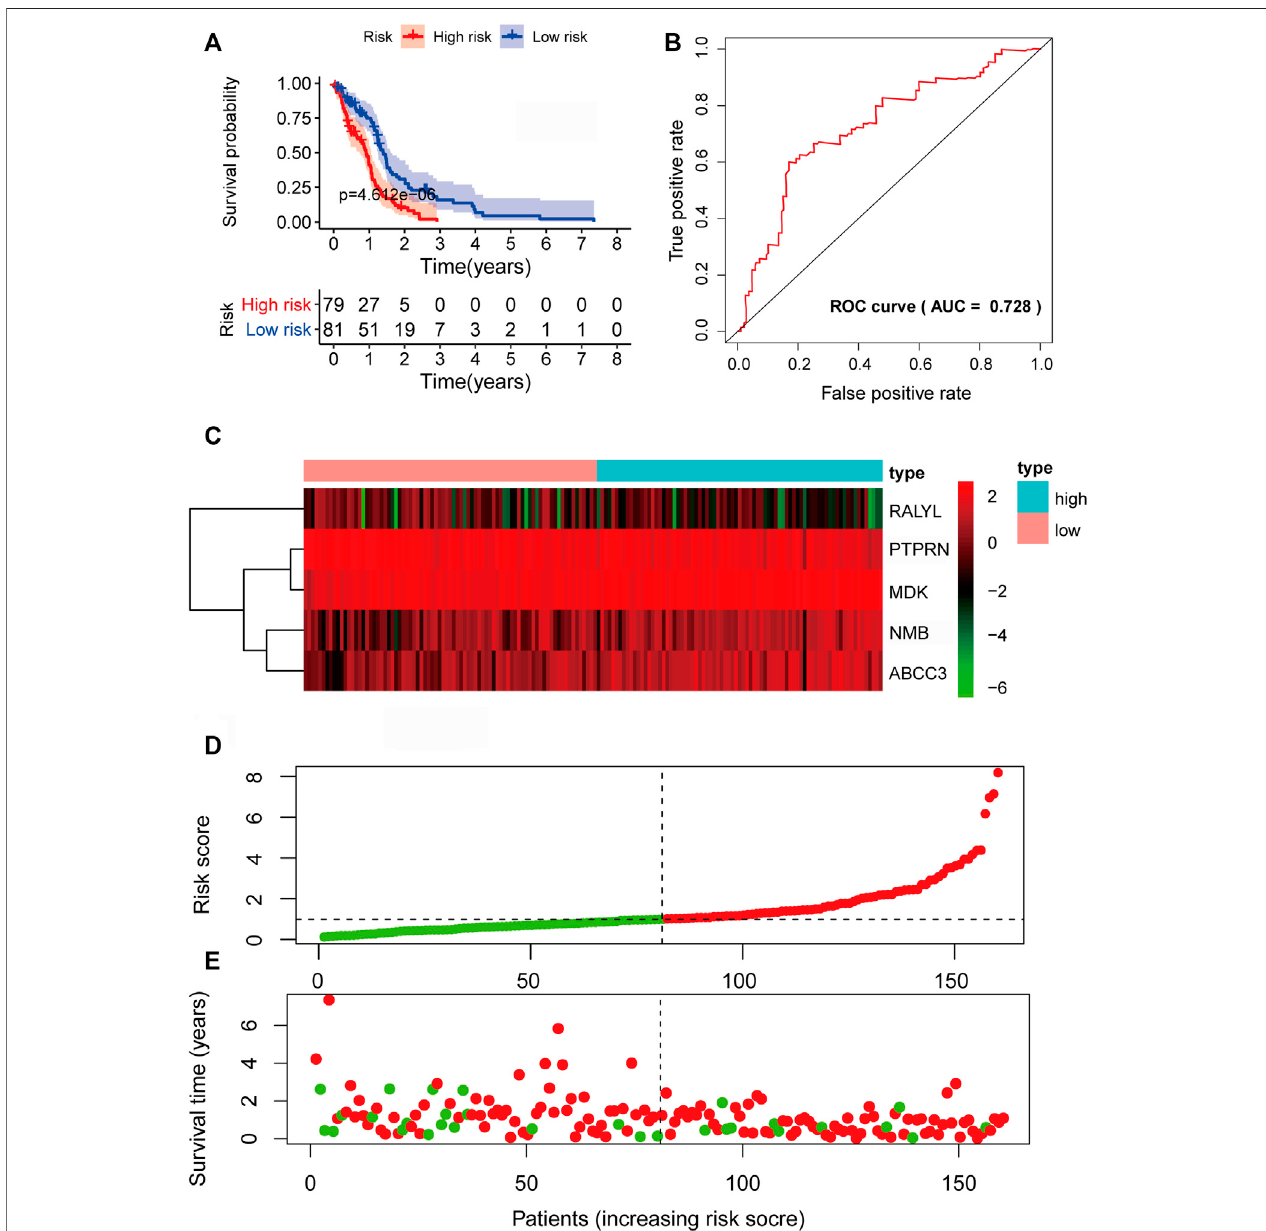
FIGURE 6 | Prognostic evaluation of the fi ve-mRNA signature in The Cancer Genome Atlas (TCGA) set. (A) Kaplan – Meier survival curve for patient overall survival (OS) in the entire TCGA set. (B) Receiver operating characteristic (ROC) curve analysis to compare the sensitivity and speci fi city of the prognosis prediction model. The mRNA expression patterns (C) , risk score distribution (D), and survival status of patients (E) in the high- and low-risk groups by the fi ve-mRNA signature. Green dot, alive; red dot,